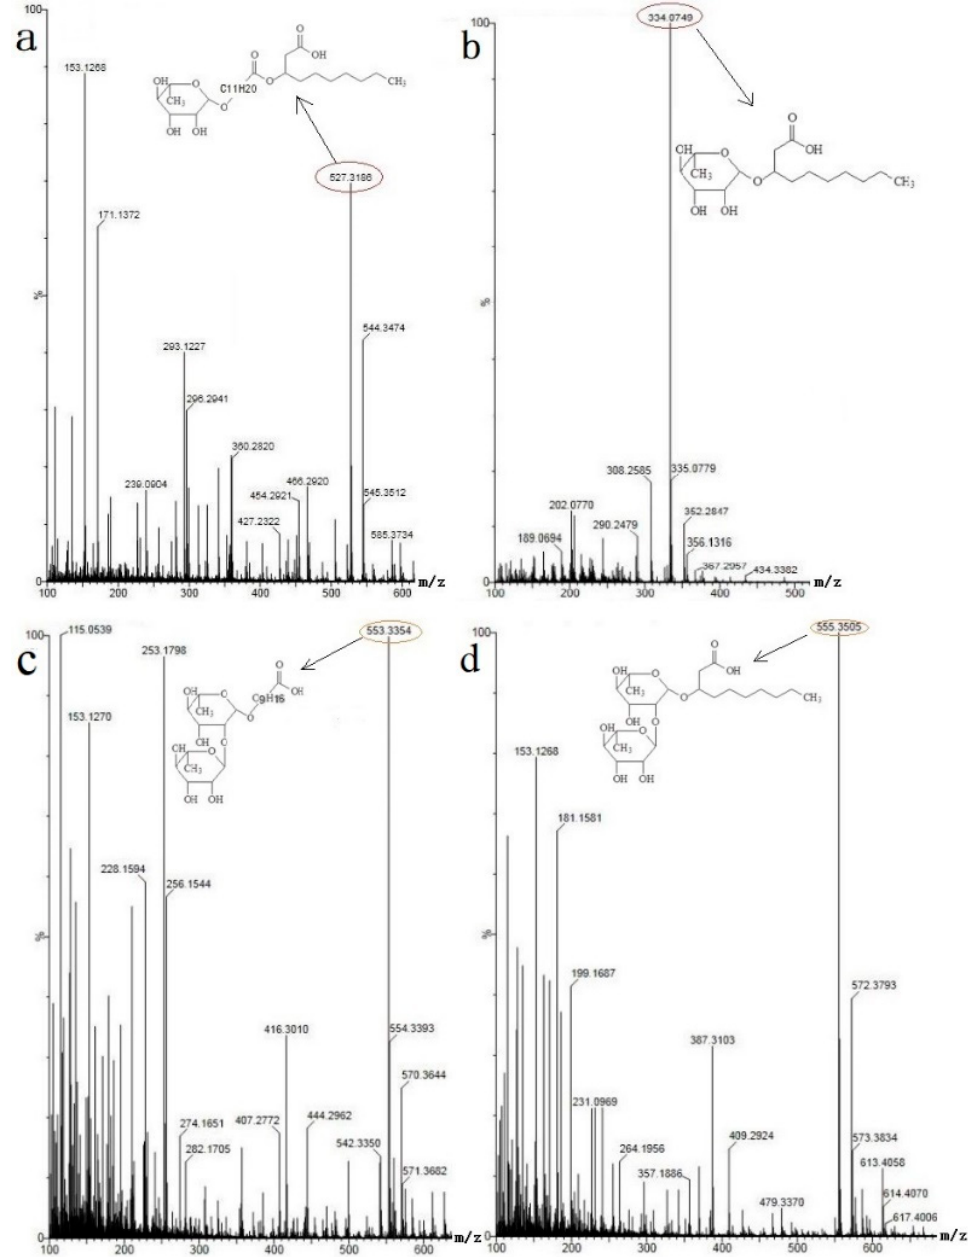
Figure 7. Mass spectrometry of bacterial secretions.